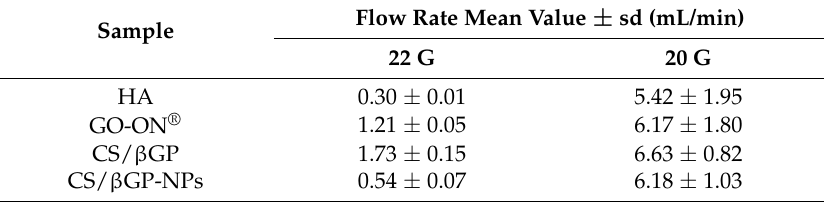
Table 2. Flow rate values of HA (15 mg/mL aqueous solution), GO-ON ® , CS/ β GP and CS/ β GP-NPs using a syringe-needle system with 22 G and 20 G needle. Results are reported as mean ± sd ( n = 3 independent